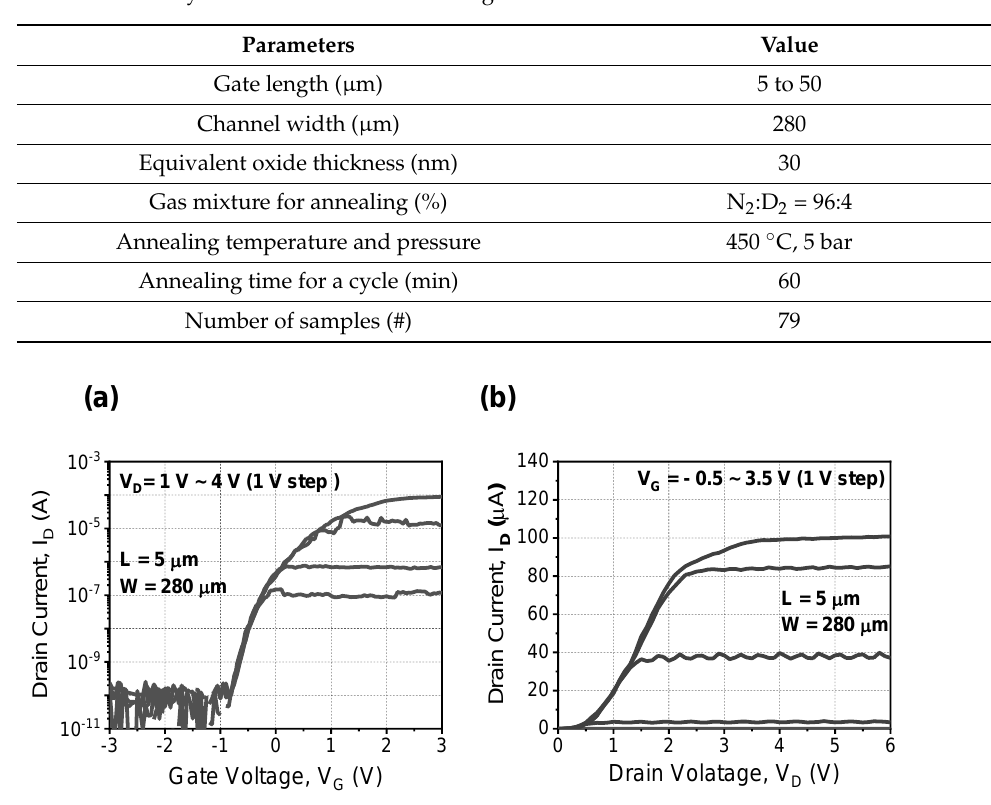
Figure 2. Measured ( a ) I D -V G and (b ) I D -V D characteristics of fabricated TV device before deuterium annealing.